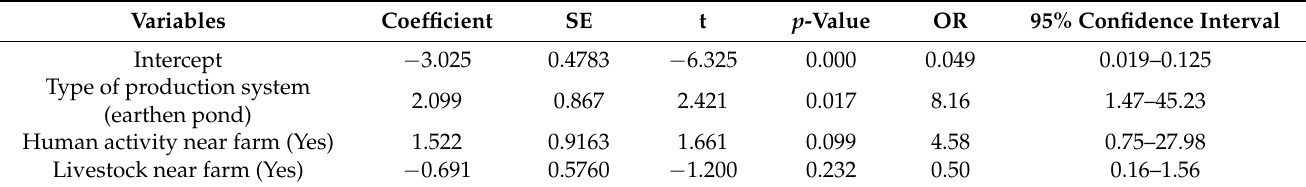
Table 4. Multilevel binary logistic regression of risk factors associated with the occurrence of MDR V. parahaemolyticus in the Asian seabass production system ( n = 13) on the west coast of peninsular